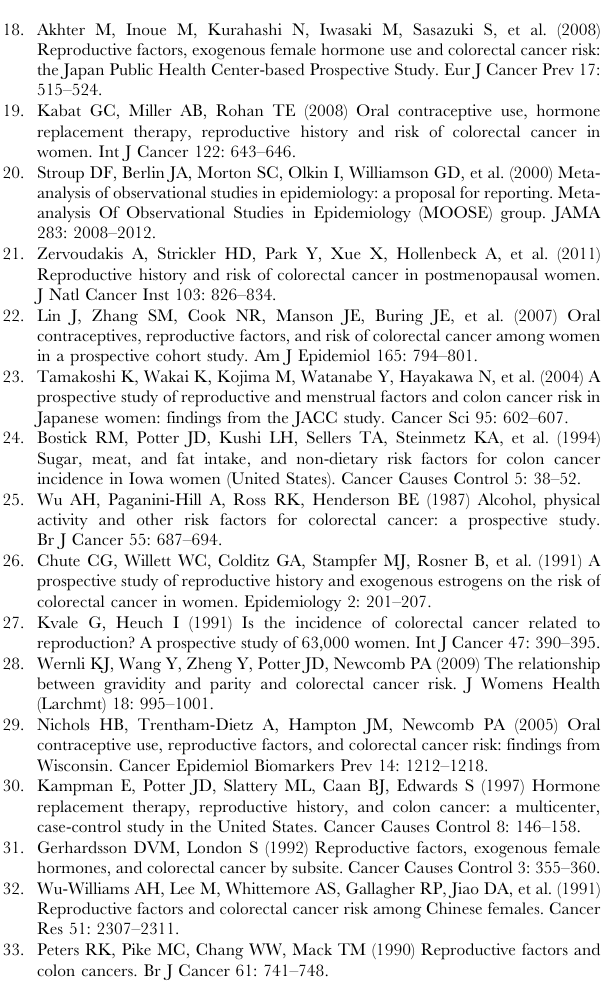
Table S1 Characteristics of studies of menarcheal age and colorectal cancer risk. Table S2 Methodological quality of the prospective studies included in the meta-analysis. Table S3 Methodological quality of the case-control studies included in the